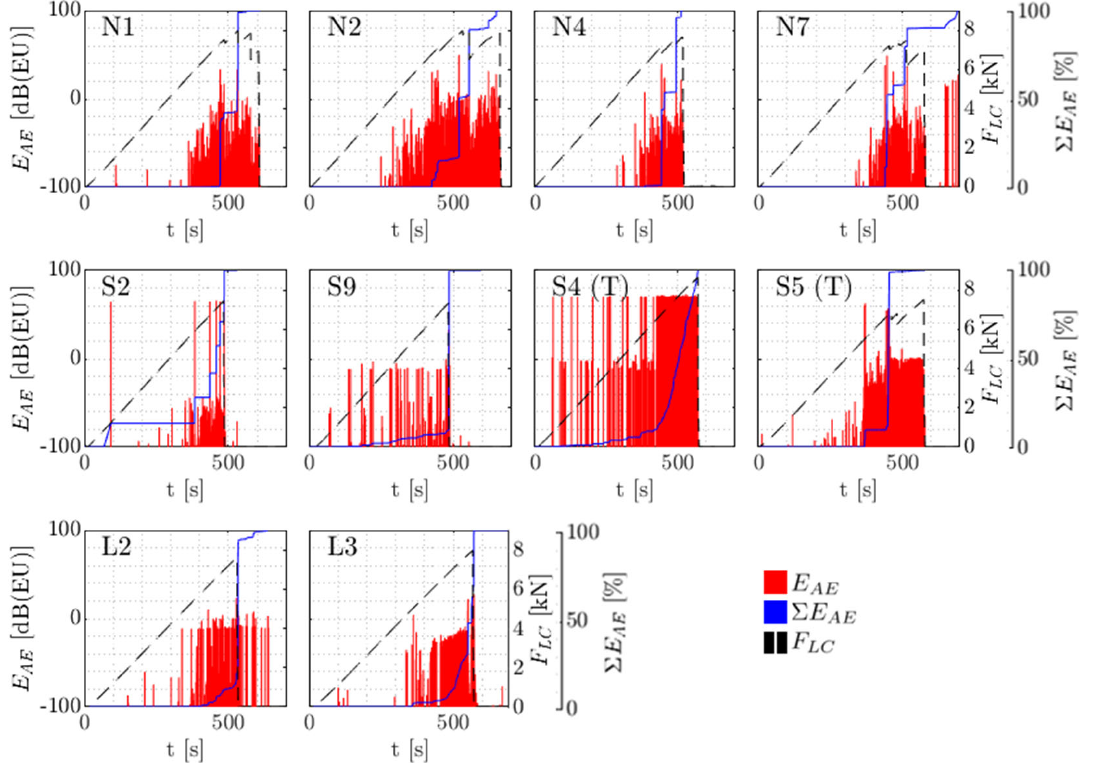
Figure 12. Energy per hit E AE and cumulative energy [% of total] over time and crosshead force F LC